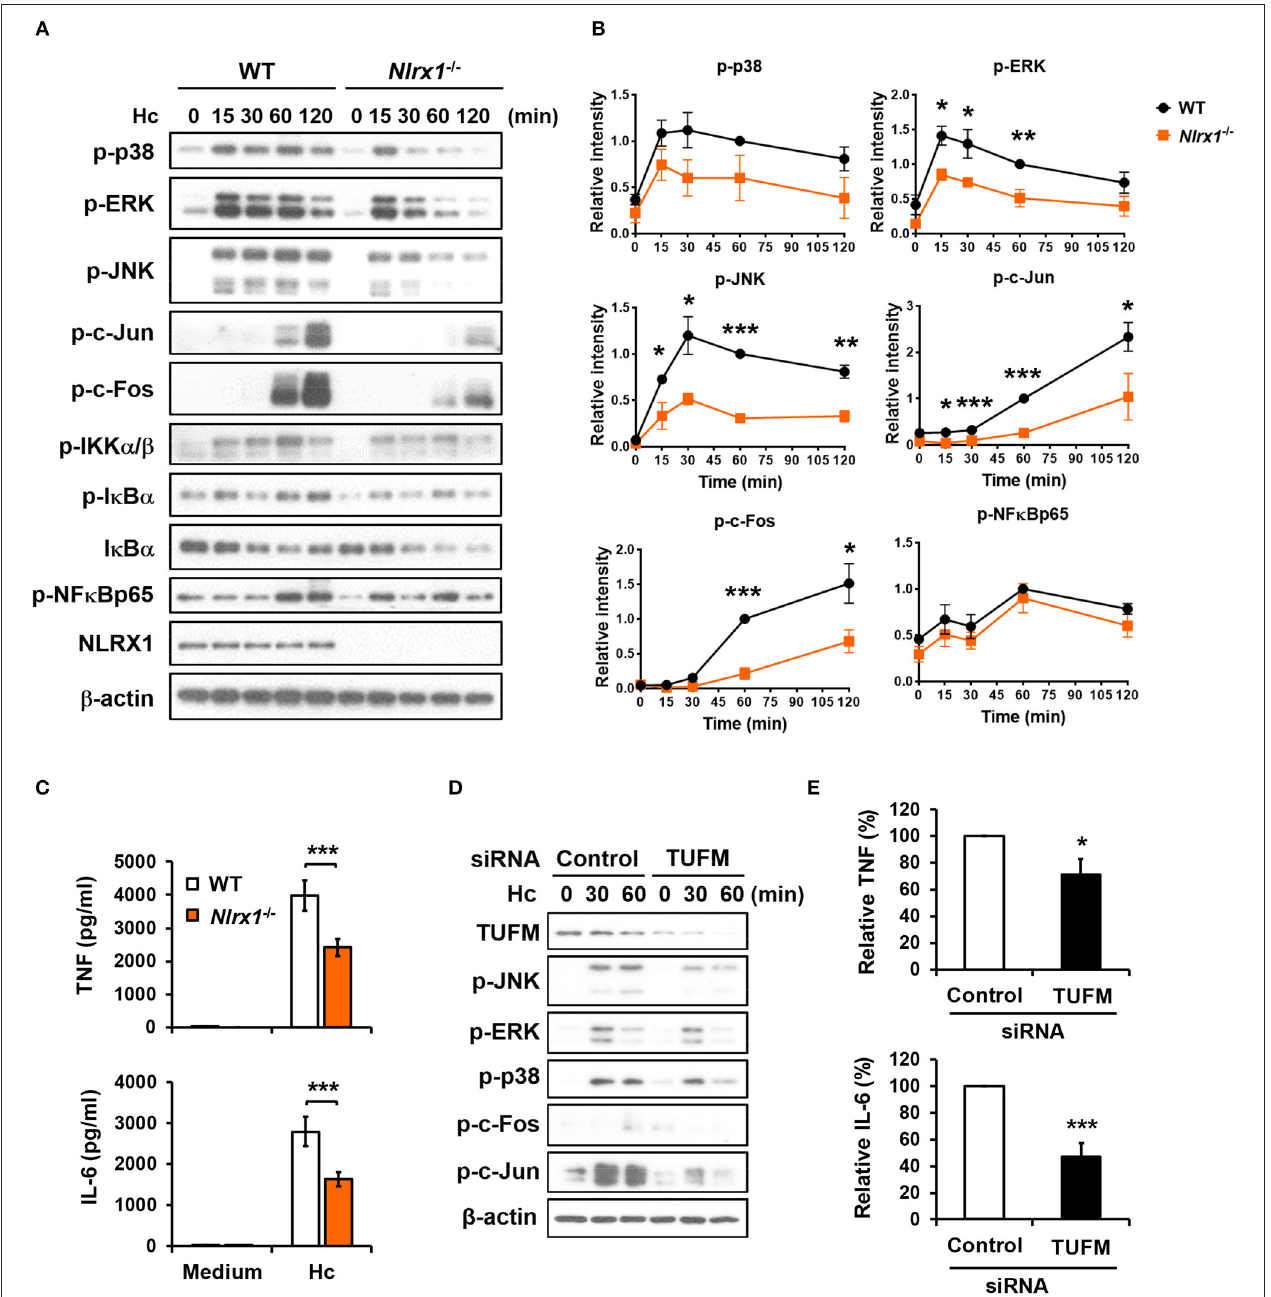
FIGURE 9 | NLRX1-TUFM is required for activation of MAPKs-AP-1 pathway and proinflammatory cytokine response to H. capsulatum . (A–C) Macrophages from WT and Nlrx1 − / − mice were stimulated with or without (0min or medium) H. capsulatum (MOI = 5). Cell lysates were collected at 15, 30, 60, and 120min after stimulation and subjected to Western blotting for the analysis of the indicated proteins (A) . Relative intensity of indicated protein normalized against the corresponding β -actin was shown in (B) ( n = 3). Supernatants were harvested at 18h after stimulation, and the concentrations of TNF and IL-6 in the supernatants were quantified by ELISA ( n = 11) (C) . (D,E) Macrophages from WT mice were transfected with control siRNA or siRNA against TUFM (50nM) for 72h. Cells were then stimulated with or without (0min) H. capsulatum (MOI = 5). Cell lysates were collected at 30 and 60min after stimulation and assessed by Western blotting for the analysis of the indicated proteins (D) . Supernatants were harvested at 18h after stimulation, and the concentrations of TNF and IL-6 in the supernatants were quantified by ELISA and are presented as the relative levels of TNF and IL-6 ( n = 6) (E) . Bars represent the mean ± SEM, * p ≤ 0.05, ** p ≤ 0.01, *** p ≤ 0.001 [2-tailed t -test (B,E) ; ANOVA with Bonferroni’s multiple comparisons post-hoc test (C)